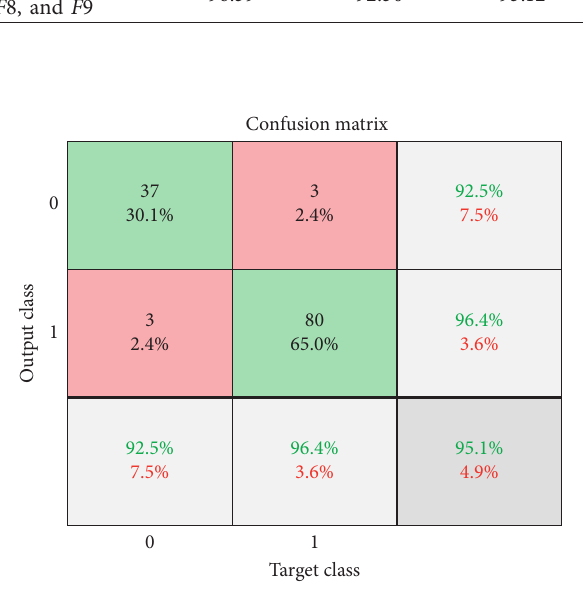
Figure 8: Classification results using data from first 128